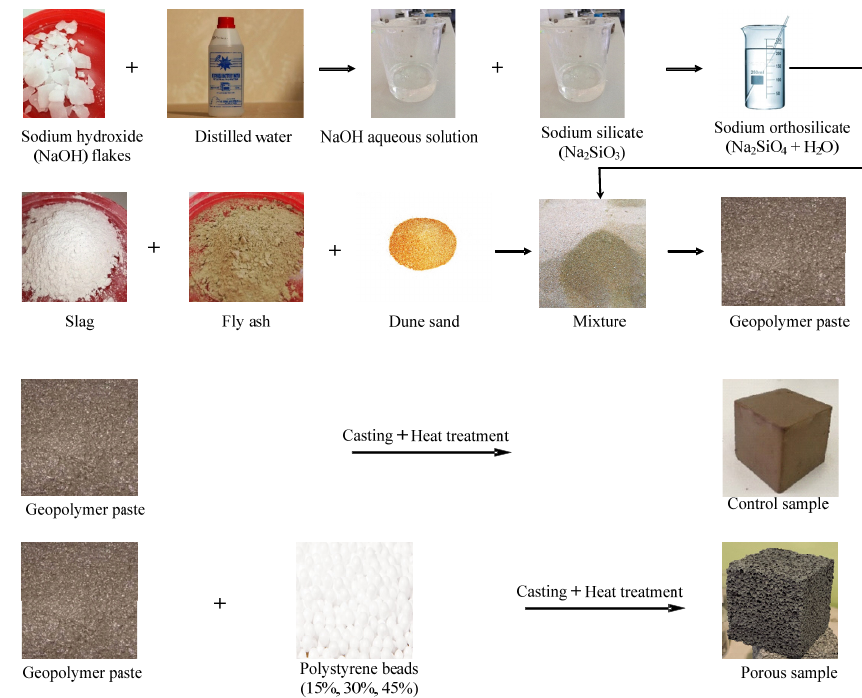
Table 1 for the completeness of the results. The size distribution curves of these materials are reported in [22]. The bonding reaction (geo-polymerization) was activated by an alkaline solution of sodium hydroxide (NaOH) and sodium silicate (Na 2 SiO 3 ).